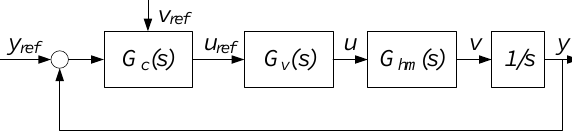
Figure 3: Bode plot of different combinations of valve dynamics and hydraulic-mechanical system